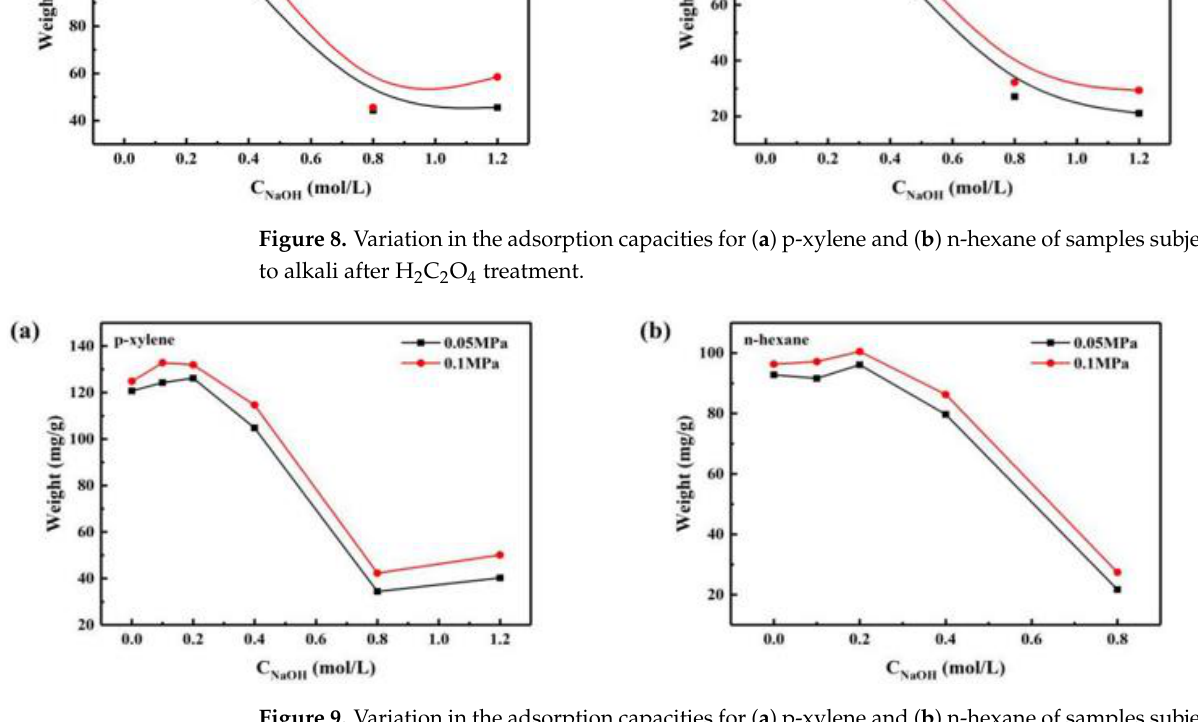
Figure 9. Variation in the adsorption capacities for ( a ) p-xylene and ( b ) n-hexane of samples subjected to alkali after HCl treatment.